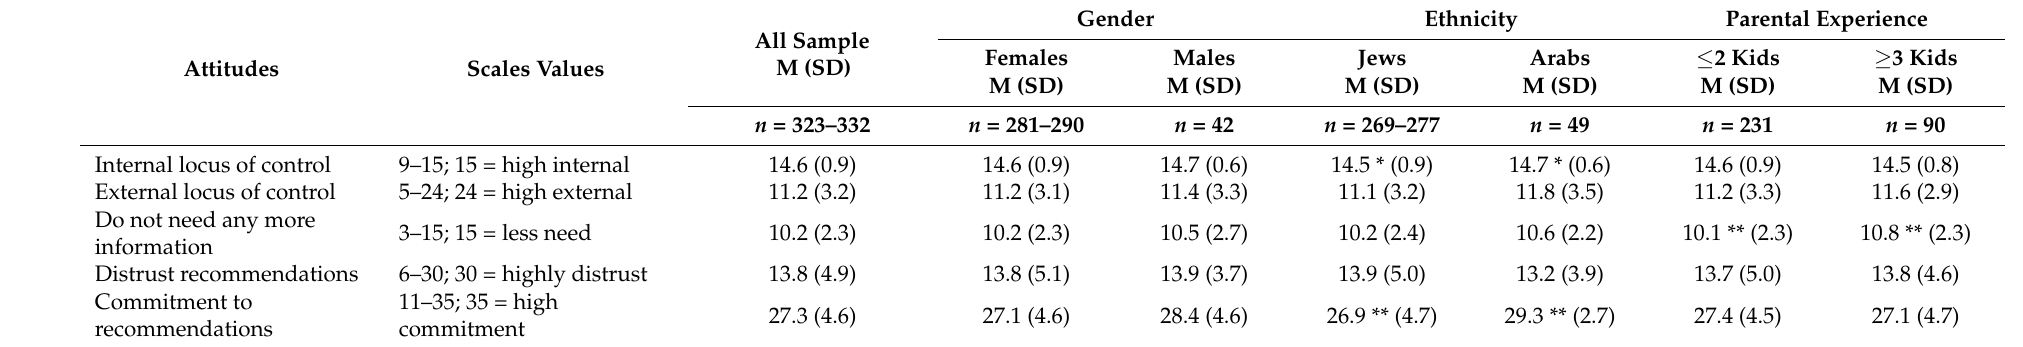
Table 3. Mean distribution of parental attitudes regard baby’s safe